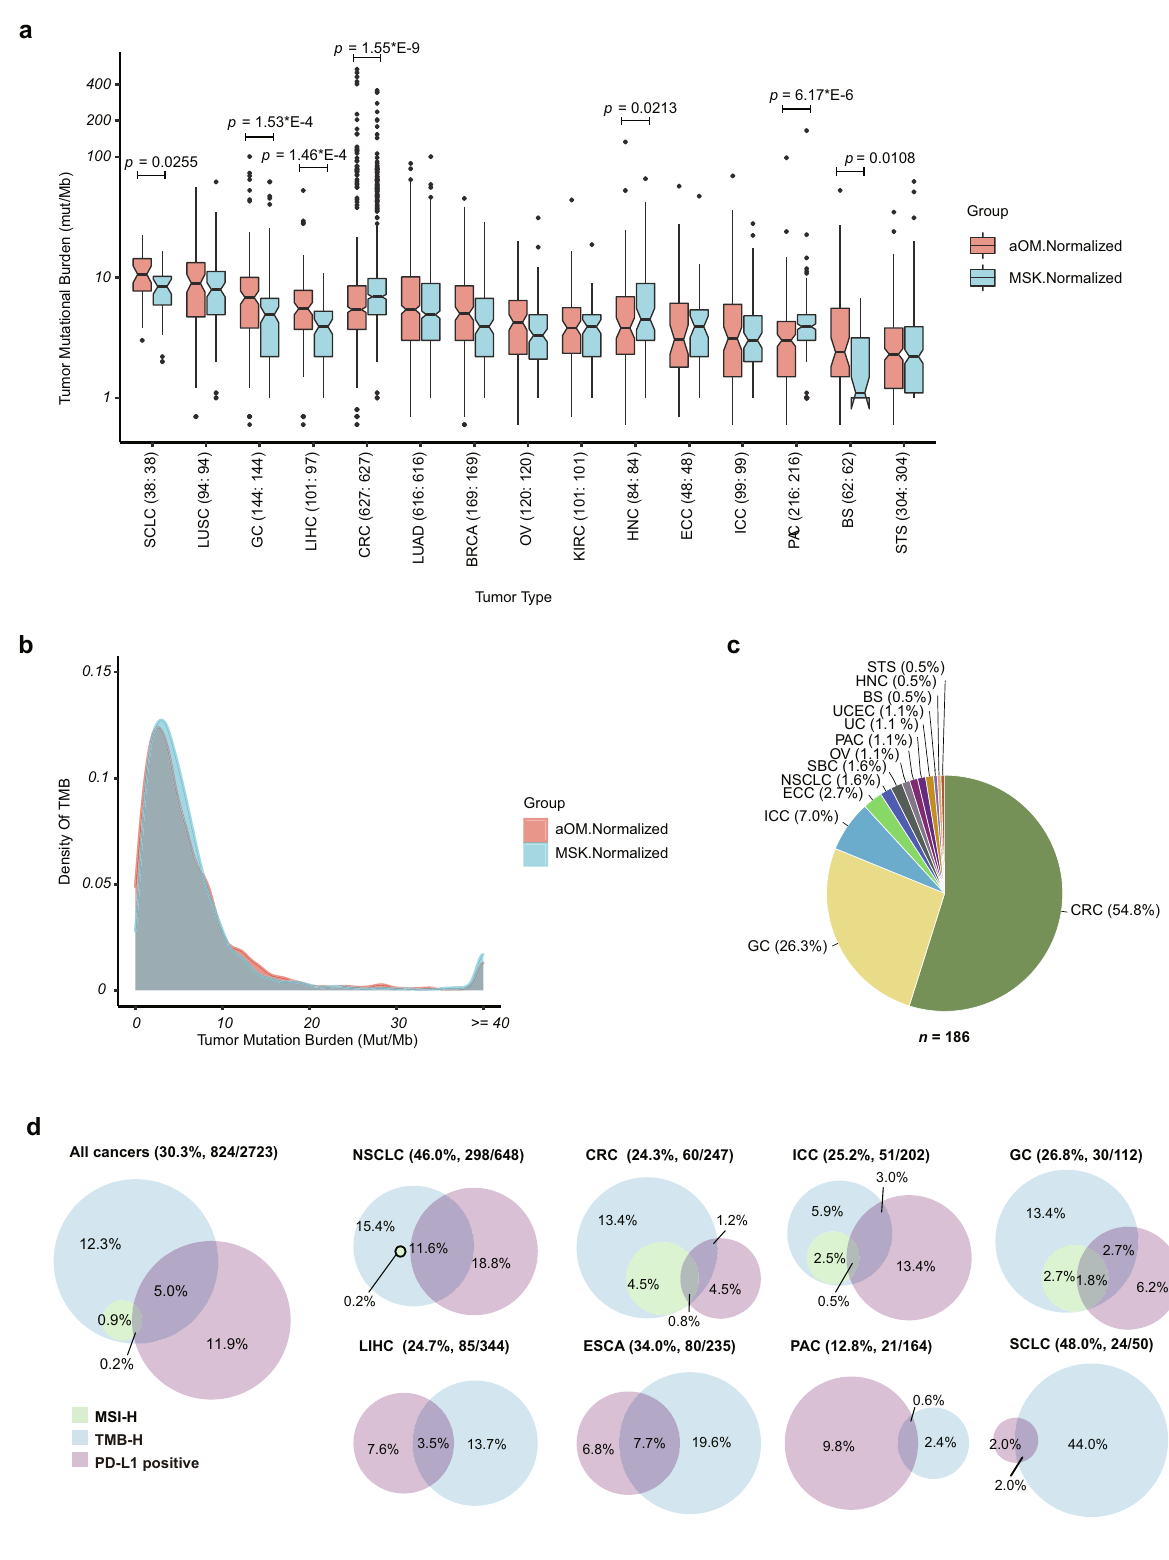
CD274 ampli fi cation (copy number ≥ 6) in the OM cohort, a proportion consistent with a previous study 21 (Supplementary Fig. 12a). Furthermore, in 30 evaluable samples with CD274 ampli fi cation tested for PD-L1 expression, the PD-L1 positive rate was 70% (Supplementary Fig. 12b). Subsequently, we also examined the mutational landscape of the 85 samples with